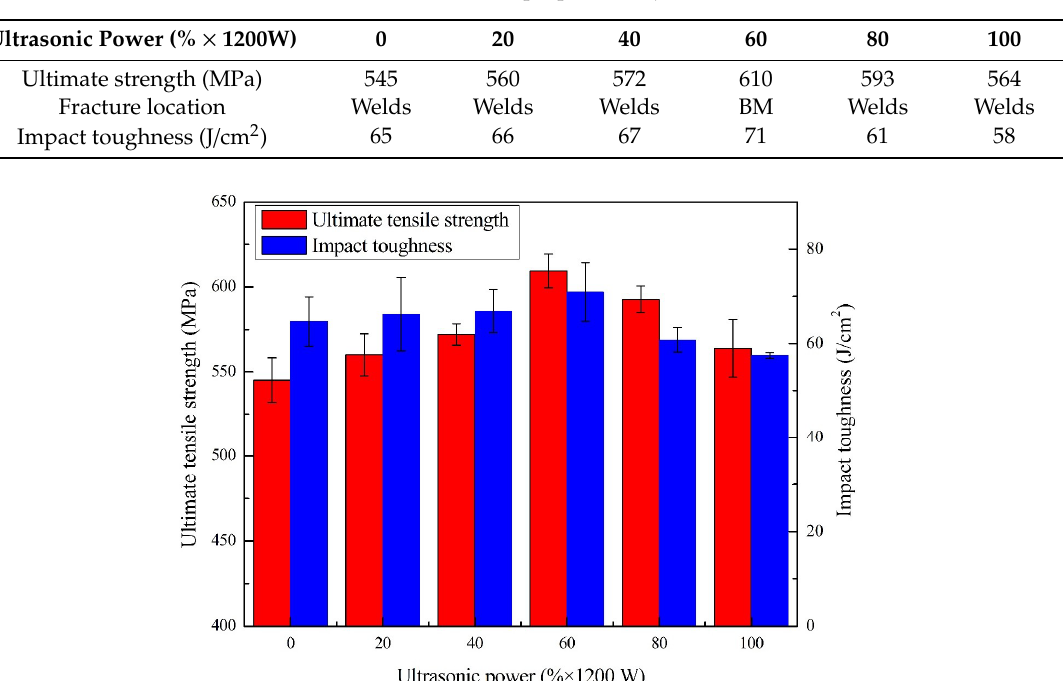
Figure 12. Ultimate tensile strength and impact toughness of the weld joints welded at different ultrasonic output power.